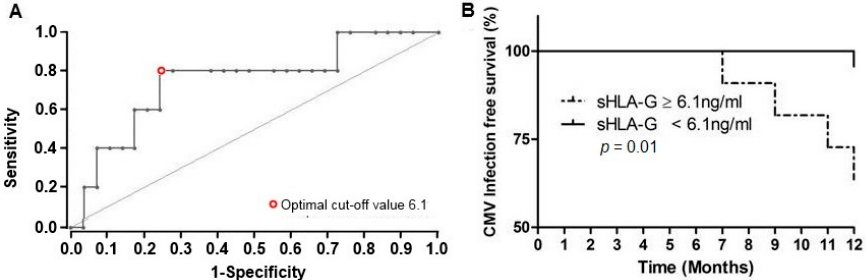
Figure 3. The correlation between plasma levels of soluble human leukocyte antigen-G (sHLA-G) and the occurrence of CMV viremia during the first year of living-donor kidney transplantation. ( A ) Receiver operating characteristic curve-based stratification was performed to predict CMV-infection free survival based on sHLA-G levels. The red open circle indicates the optimal cut-off value with a sensitivity of 80.0% and a specificity of 75.8%; black dots represent differing cut-off values ( B ) patients with higher sHLA-G levels ( ≥ 6.1 ng/mL) had a significantly increased likelihood of CMV infection compared to patients with low sHLA-G levels (<6.1